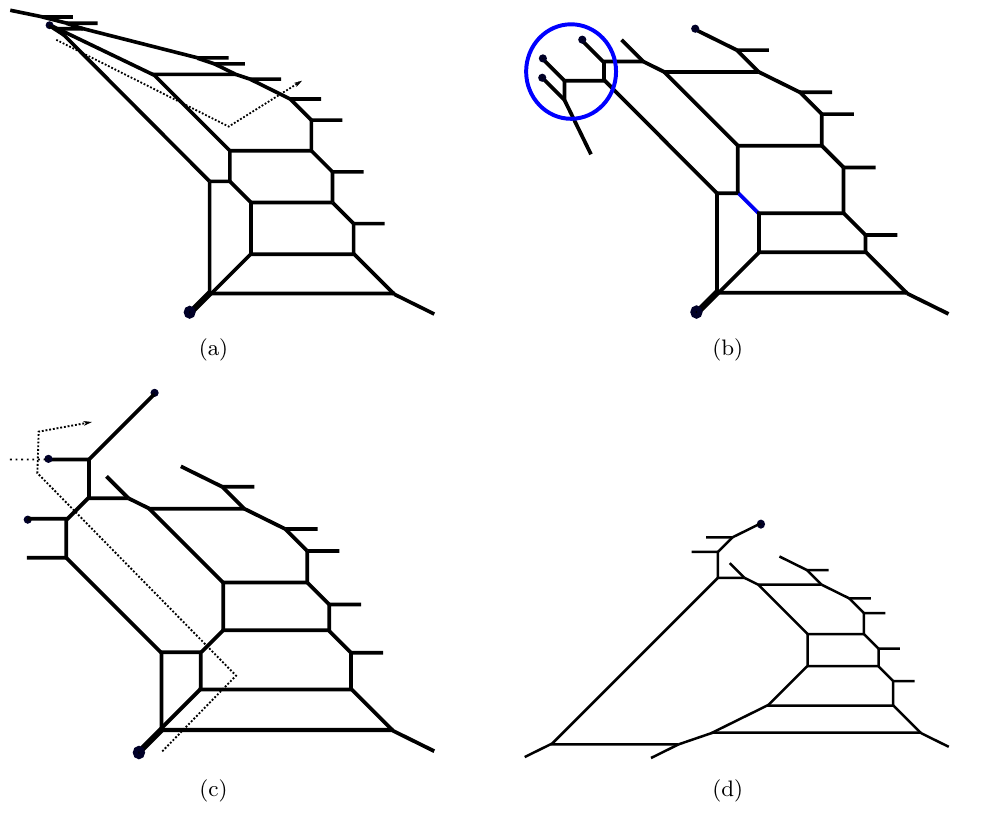
Figure 36 . (a) A 5-brane web diagram for the SU(6) gauge theory with N TAS = 1 (b) The diagram after moving the (2 ; (cid:0) 1) 7-brane along the arrow in (cid:12)gure 36(a). (c) The diagram after we (cid:13)op the line in blue and also move 7-branes in the blue circle in the diagram in (cid:12)gure 36(b). (d) The diagram of the quiver [2 F ] (cid:0) SU(2) (cid:0) SU(5) along the arrow in (cid:12)gure